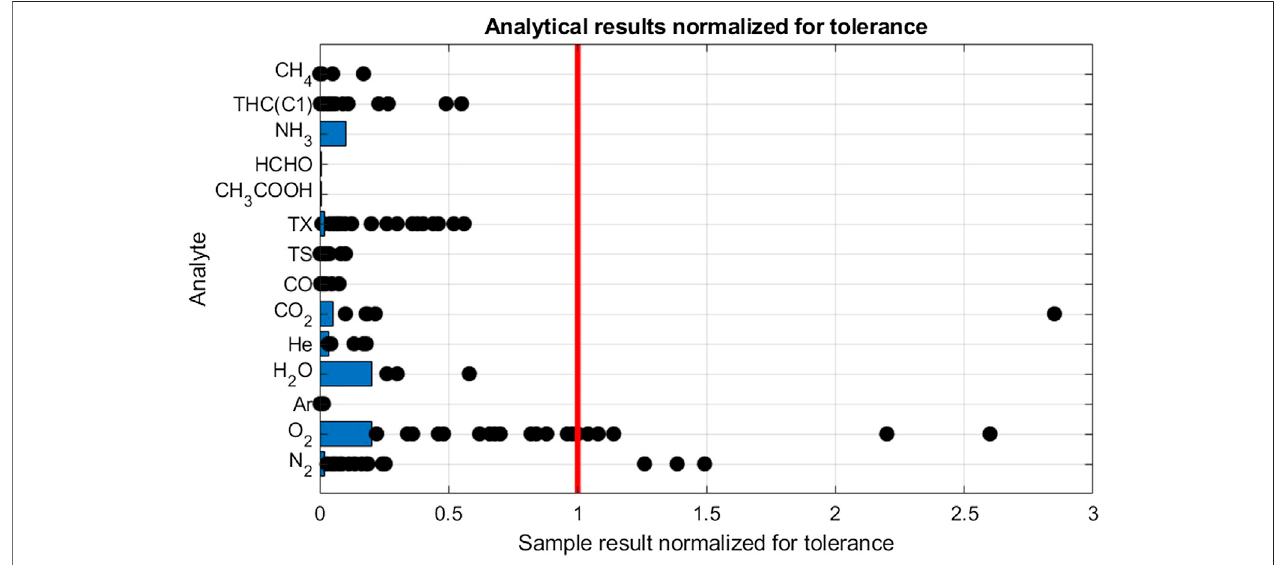
FIGURE 3 | Analytical results of gas samples from HRS. Results are normalized by dividing the results by the hydrogen fuel tolereance for the individual analytes. The Limit of Detection, indicated with blue bars, is also normalized. For scalability, the highest results for N 2 (4.8) and THC(C1) (15) were omitted.